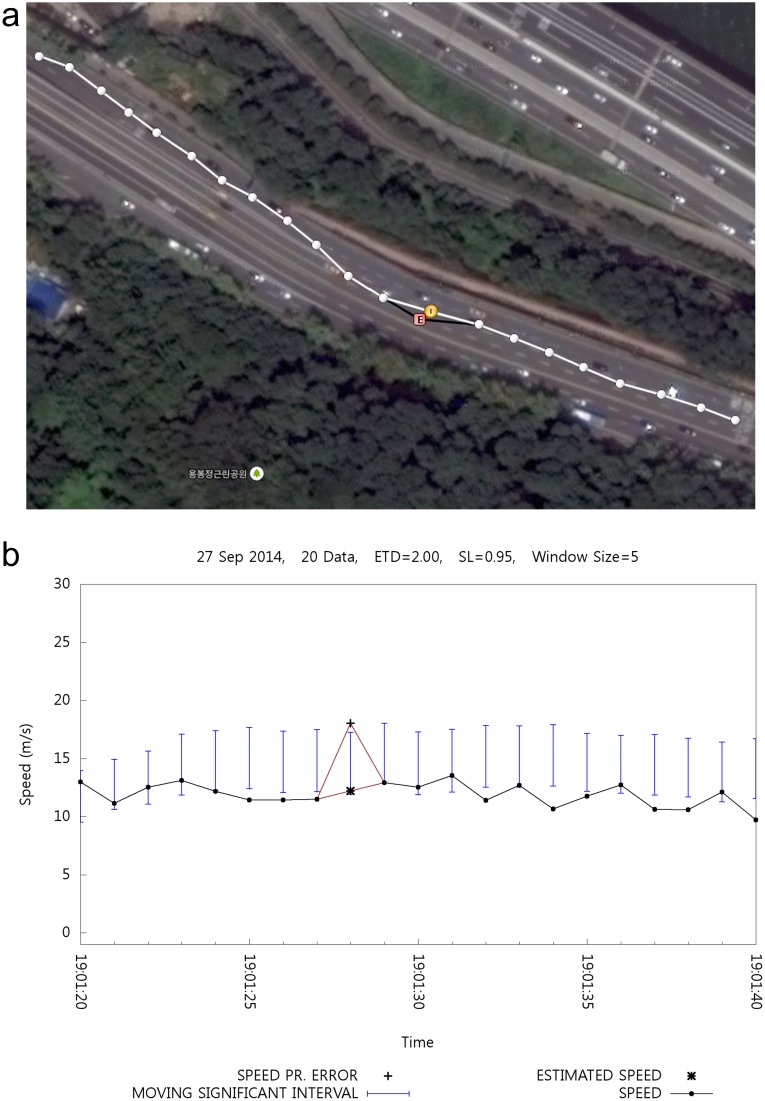
Effect of Location Estimation.